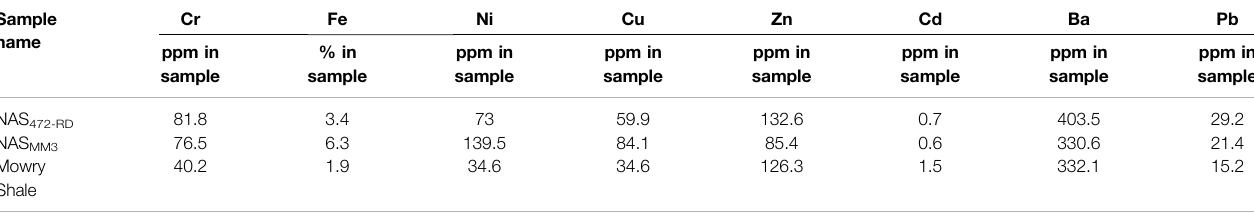
TABLE 5 | Shale metal concentrations with values reported in percentage and